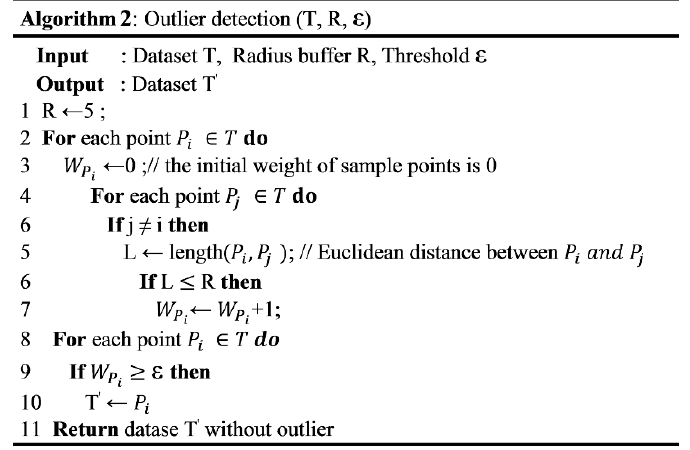
Figure 11. Pseudo-code depicting Algorithm 2.